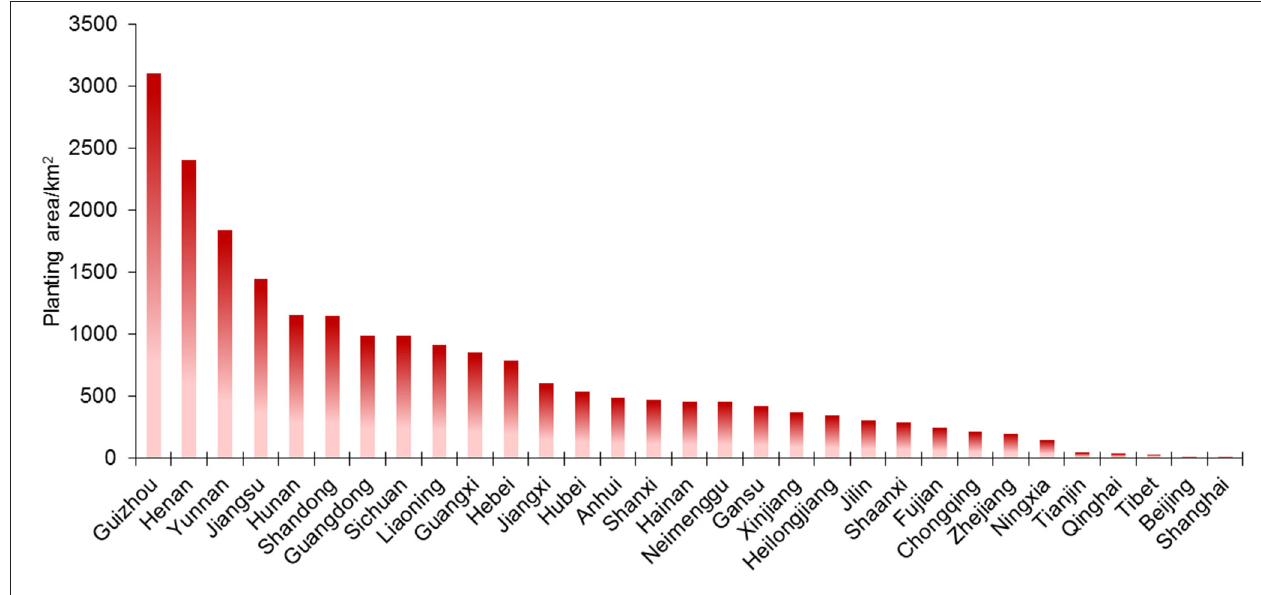
FIGURE 2 | Pepper planting area of each province of China.